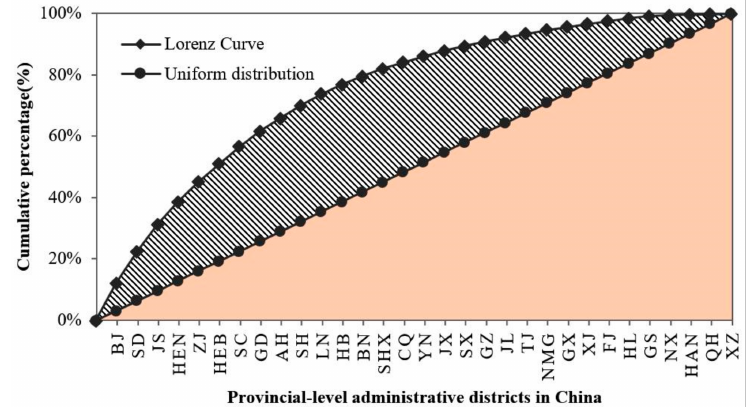
Figure 4. Lorenz curve of spatial distribution of picking orchards in